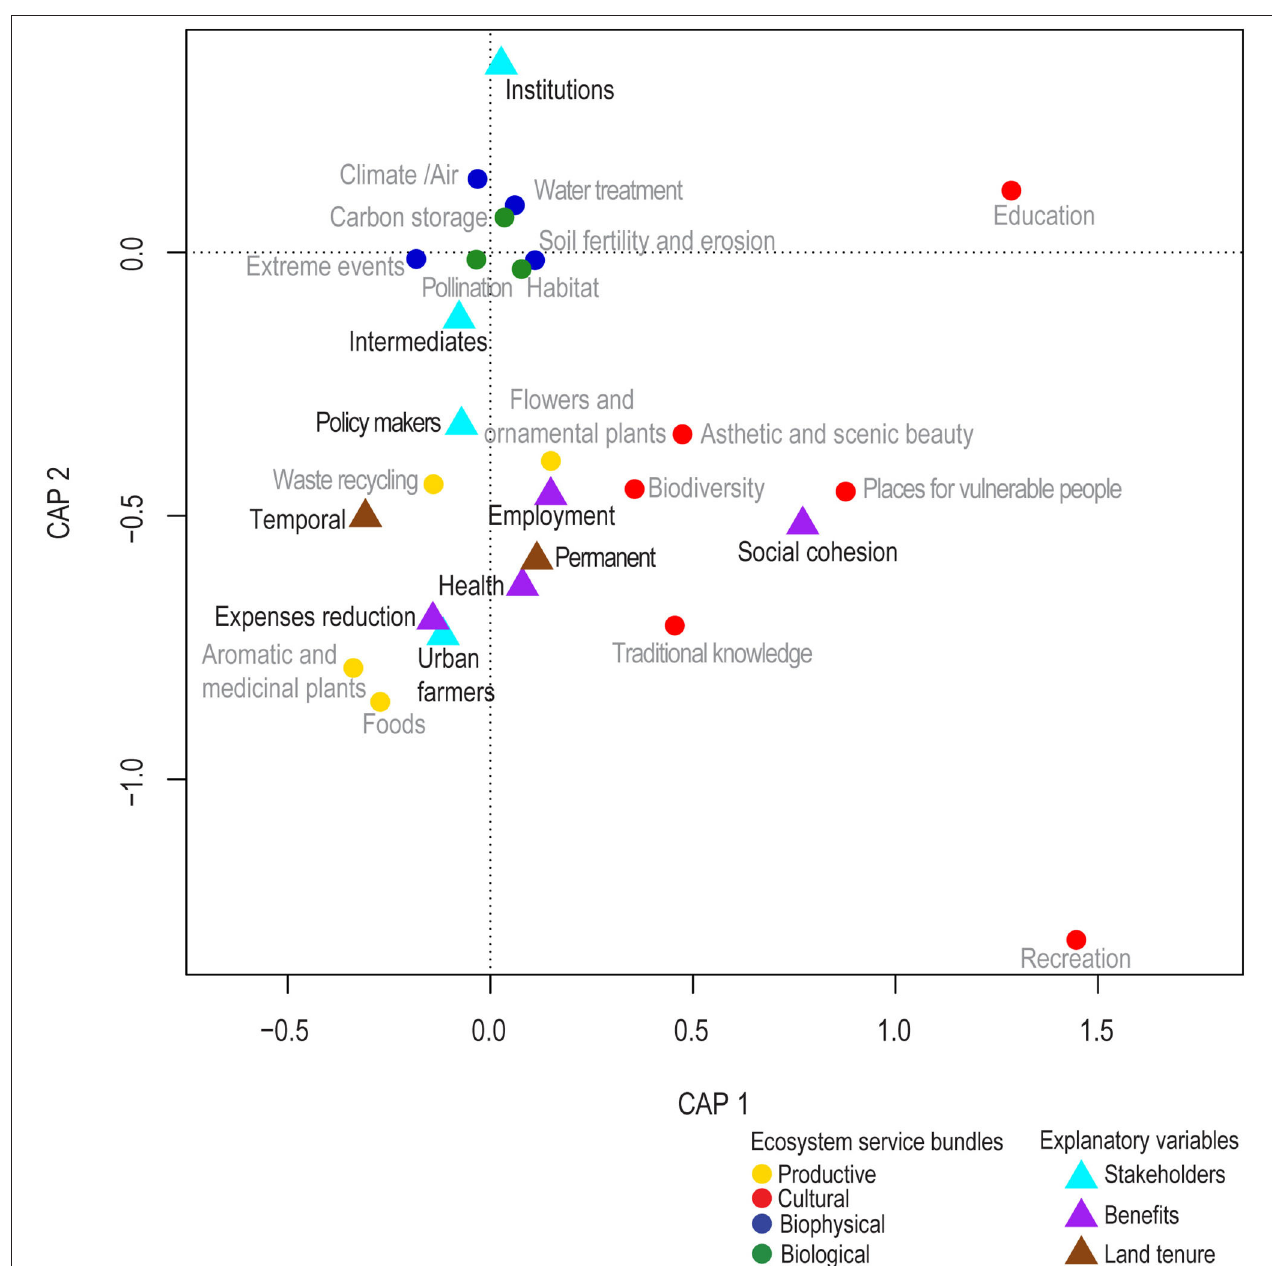
FIGURE 2 | db-RDA of ecosystem service bundles (response variables) and stakeholders, benefits, and land tenure (explanatory variables). CAP is the name of the R function ( capscale ) used to carry out the analysis with binary data.